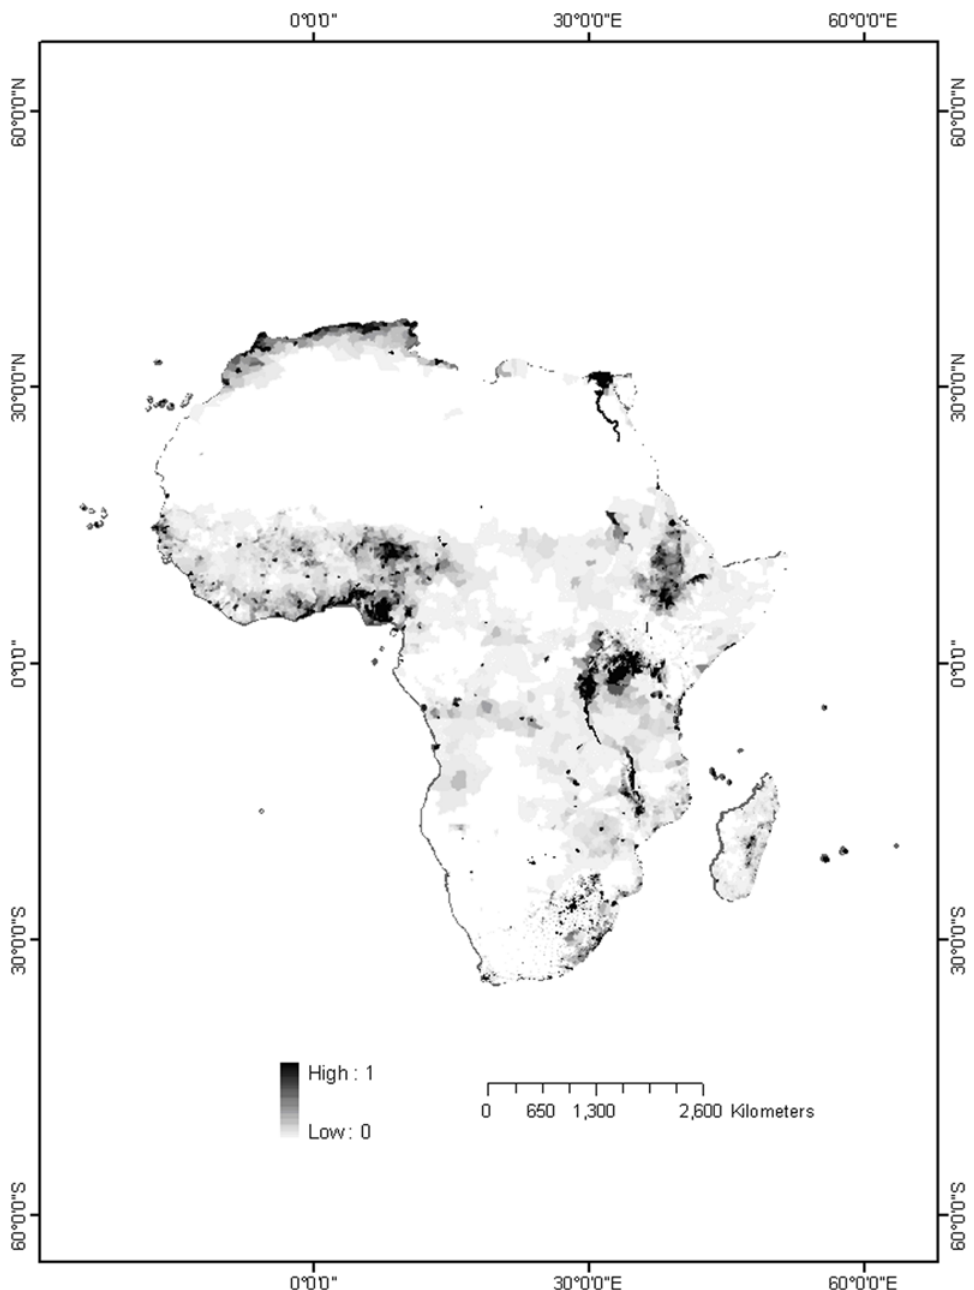
Figure 1. Population density in Africa. The population densities have been normalized so as to range over the unit interval.